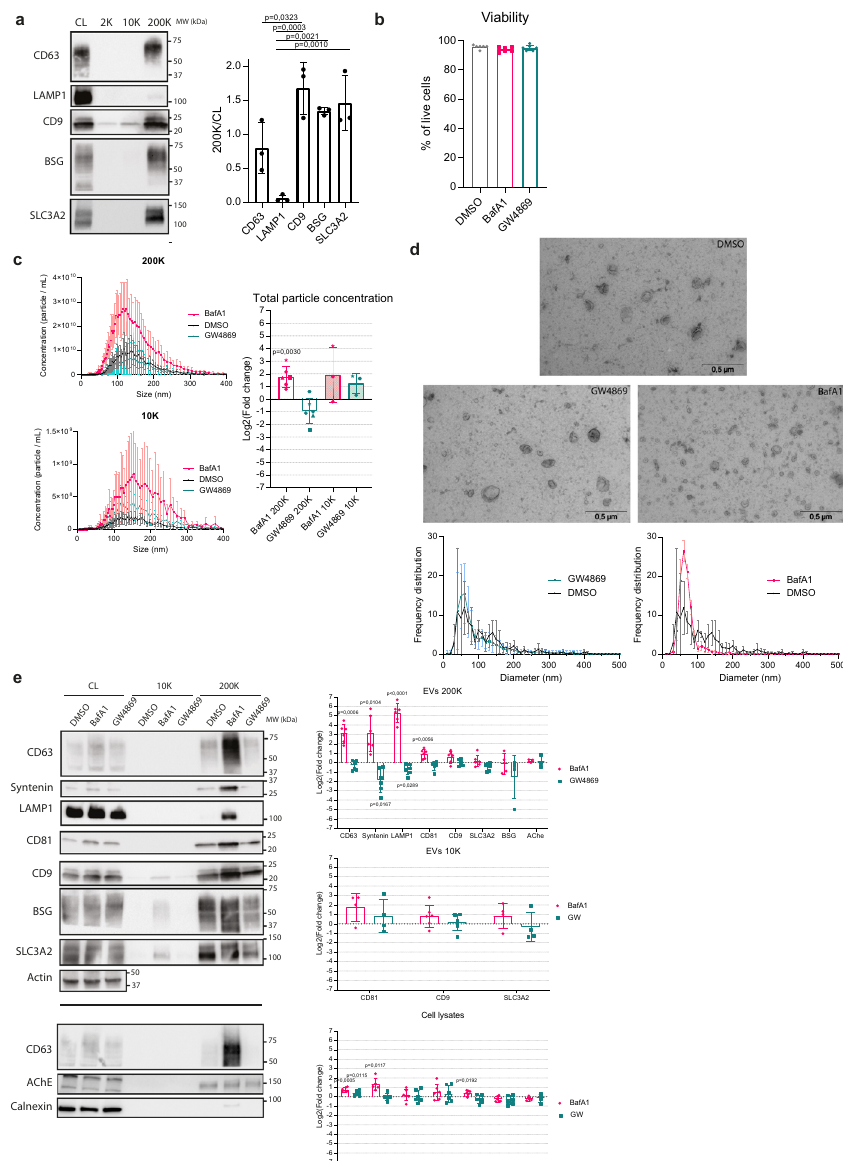
Fig. 7 Different effect of BafA1 and GW4869 on secretion of CD63, CD9, and the novel EV markers. a Western blot showing CD9, CD63, and CD81, and the new markers LAMP1, BSG, and SLC3A2 in cell lysates (CL) and the pellets obtained from HeLa conditioned media after differential ultracentrifugation (2 K, 10 K, and 200 K). The loaded material comes from 20 × 10 6 cells for the centrifugation pellets, and from 0.2 × 10 6 cells for the cell lysate. One representative image. For each marker, mean ± SD of the quanti fi cation of the signal in 200 K pellets divided by the signal in the total lysate, run on the same blot, is shown for 3 independent experiments. Ordinary one-way ANOVA, Tukey ’ s multiple comparisons test. b Viability of HeLa cells at the end of the 16 h medium conditioning period in the presence of DMSO (control) or BafA1 (100 nM) or GW4869 (10 μ M) drugs, measured by trypan blue in 6 independent experiments, mean ± SD is represented. No signi fi cant difference observed with an ordinary one-way ANOVA, Tukey ’ s multiple comparisons test. c Nanoparticle tracking analysis (NTA) of EVs obtained by differential ultracentrifugation from equal numbers of HeLa cells treated with DMSO (control), BafA1 or GW4869 during 16 h. The particles concentration according to their size and the fold change of the total particle concentration between treated and control conditions are represented as mean ± SD of 5 (200 K) or 3 (10 K) independent experiments. Two-tailed one sample t test to compare each condition with a theoretical mean of 0. d TEM analysis (1 representative image) and size measurement (in 3 independent experiments) of EVs in 200 K pellets of cells exposed to DMSO, BafA1 or GW4869. Mean± SD of the frequency distribution of CD63 and CD9 in EVs of different diameters is represented. e Representative Western blot of cell lysates from 0.2 × 10 6 HeLa cells and EVs from 20 × 10 6 HeLa cells treated with DMSO, BafA1, or GW4869, corresponding to the samples of b – d . The mean fold change ± SD between DMSO and BafA1 or GW4869 treatment of the bands intensity in the 200 K and 10 K pellets divided by the cell lysate is represented for 6 independent experiments. Two-tailed one sample t test to compare each condition with a theoretical mean of